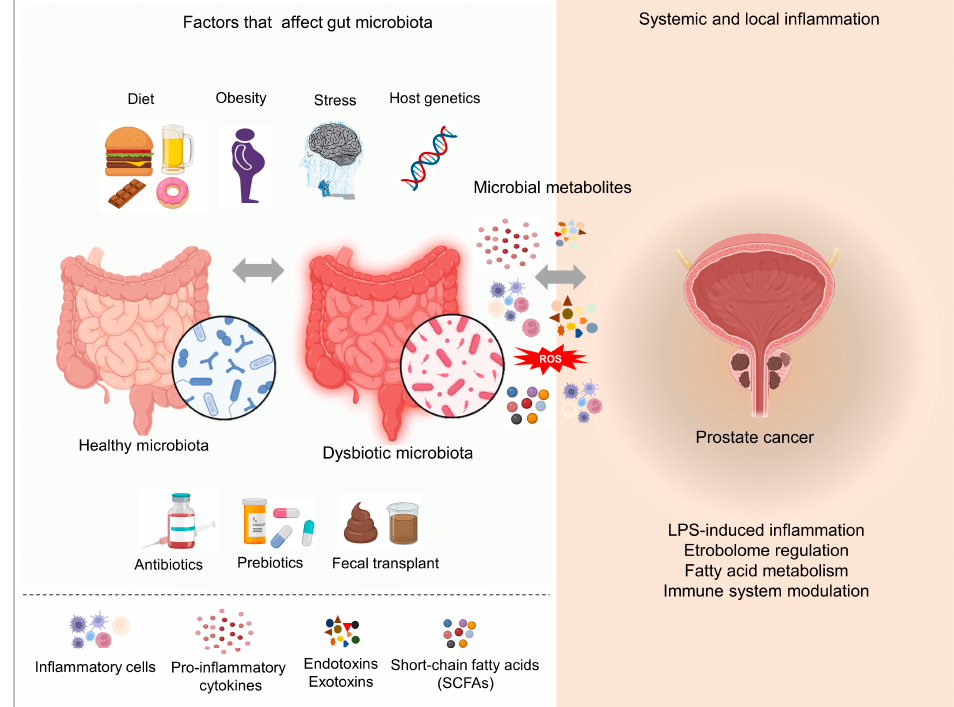
Figure 2. Factors affecting gut microbiota composition and mechanisms of action of the gut microbiome and the correlation with PCa. Image created using